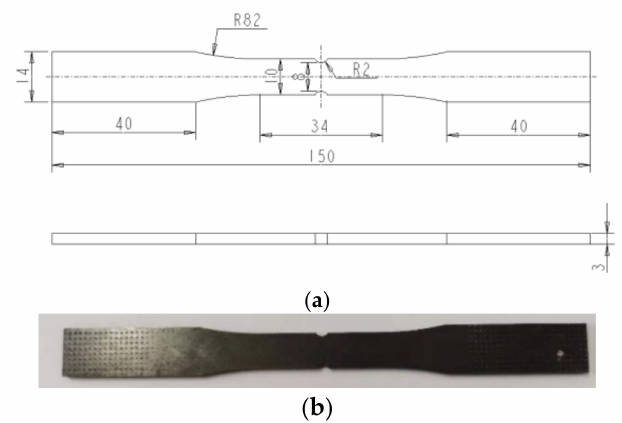
Figure 11. Q355 notched specimen: ( a ) specimen dimensions (unit: mm); ( b ) physical